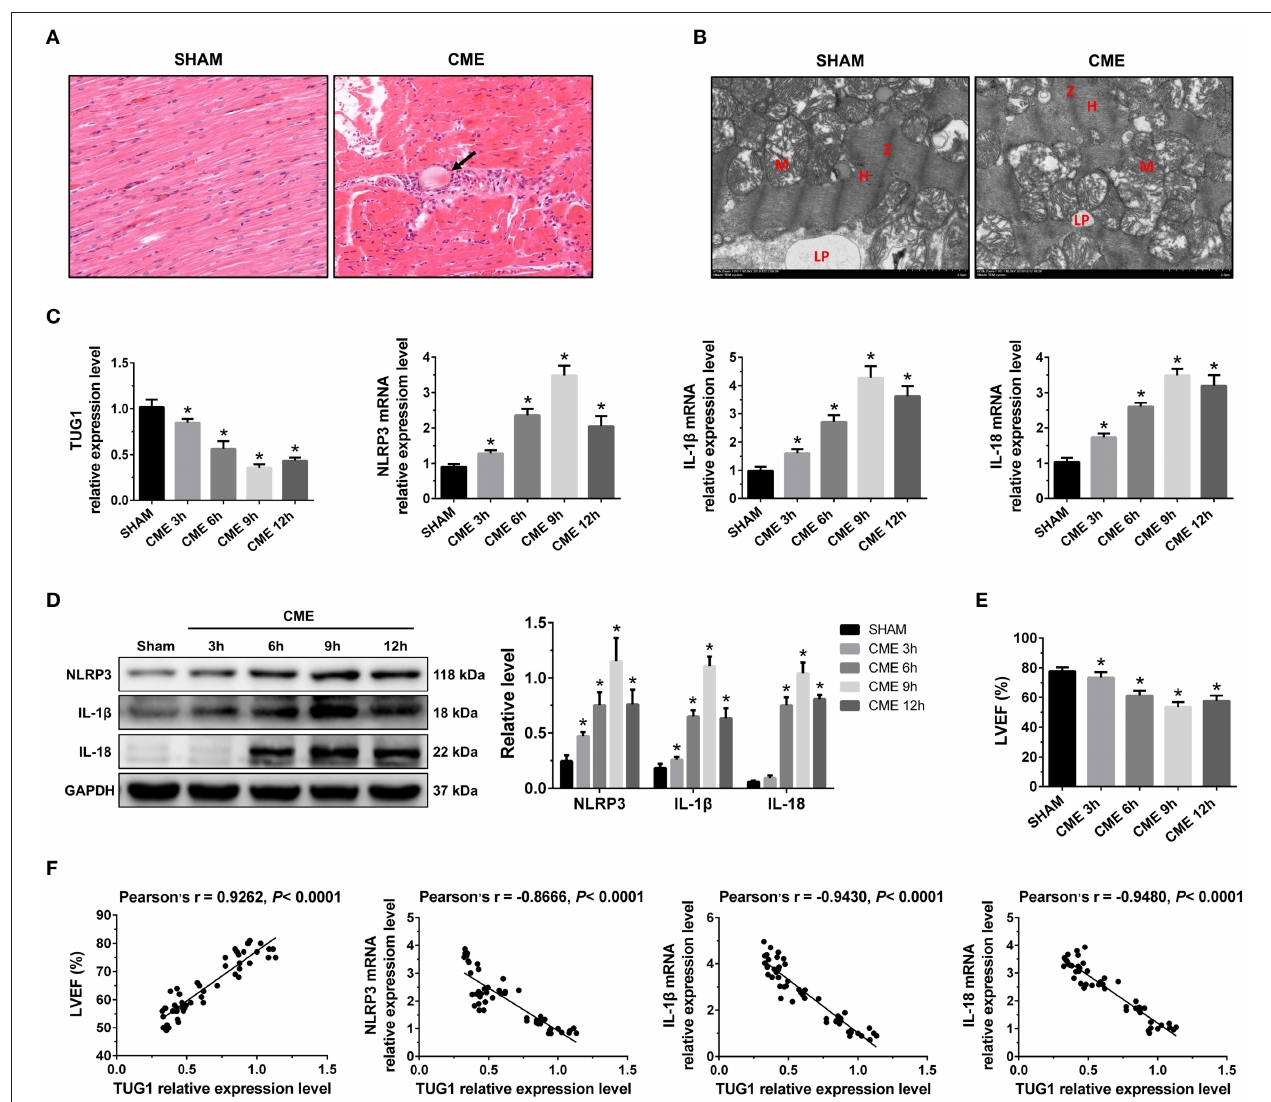
FIGURE 1 | The expression pattern of lncRNA TUG1 in myocardial tissue following CME. (A) Myocardial tissue samples stained with hematoxylin and eosin (H&E). Microspheres are marked using black arrow ( × 200; scale bar = 50 µ m). (B) Myocardial tissue samples were assessed via TEM ( × 30,000; scale bar = 2 µ m). M, mitochondria; LP, lipid droplets; H, H-bands; Z, Z line. (C) Myocardial TUG1, NLRP3, IL-1 β , and IL-18 mRNA levels were assessed via qRT-PCR ( n = 10). (D) Levels of myocardial NLRP3, IL-1 β , and IL-18 protein were assessed via Western blotting. GAPDH served as a normalization control ( n = 3). (E) Echocardiography was used to assess cardiac function and to quantify LVEF ( n = 10). (F) TUG1 levels were positively correlated with LVEF and negatively correlated with NLRP3, IL-1 β , and IL-18 mRNA expression. Data are mean ± SEM from three or more independent experiments. * P < 0.05 vs. SHAM group.